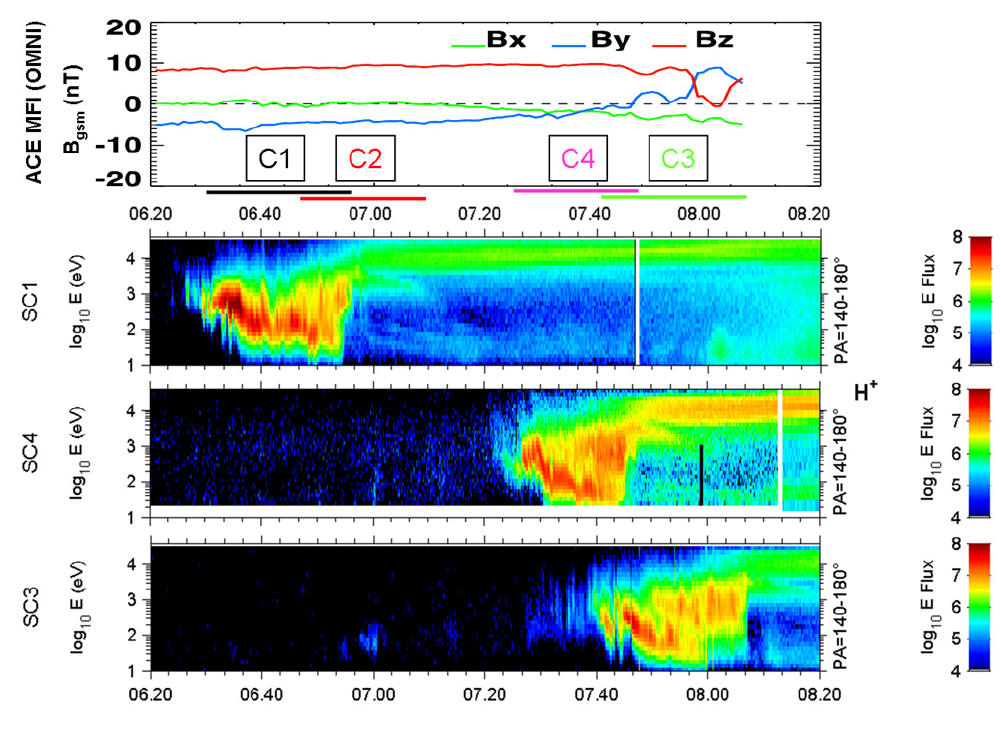
Fig. 1. From top to bottom, the 3 components of the IMF measured by ACE (shifted by 65min to take into account the propagation time) and energy-time ion spectrograms from Cluster-CIS on board spacecraft 1, 4 and